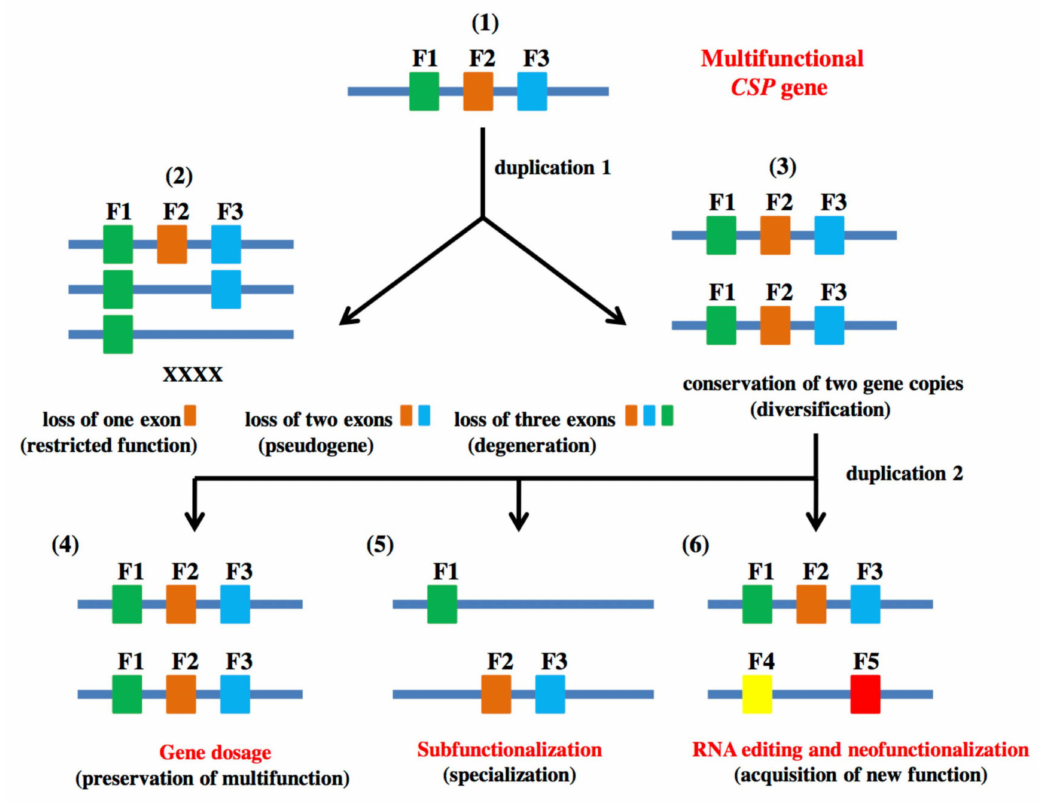
Figure 4. Evolution of CSPs for neofunctionalization. ( 1 ) At some point far back in time (Bya), the original ancestor CSP gene retains three functions (three exons: F1, F2 and F3). The outcome of the first early duplication (duplication 1) is a pair of tandem paralogous genes strictly identical to the original gene. ( 2 ) Duplication 1 can lead to loss of one exon (restricted function), loss of two exons (unexpressed pseudogene: BmorCSP5 , BmorCSP16 , BmorCSP18 and AAJJ0269A1B [14,38]), or loss of the three exons (degeneration /